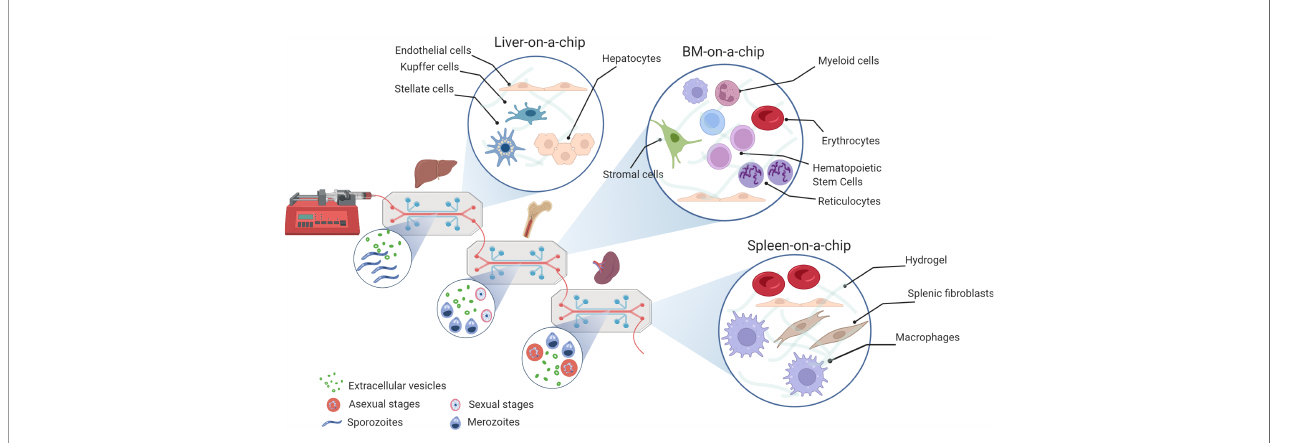
FIGURE 3 | Organs-on-a-chip for cryptic infections in malaria research. Micro fl uidic system connecting the minimal functional units of a liver, bone marrow and spleen-on-a-chip on a PDMS support with controlled perfusion rate. Different molecular-design hydrogels can be used for tissue dimensionality, i.e., matrigel, alginate, fi brin/collagen. The small circles show the presence of malaria parasites and extracellular vesicles; the big circles show 3D cultures with illustrative examples of cell types present in each speci fi c organ (Created with BioRender.com by Nuria